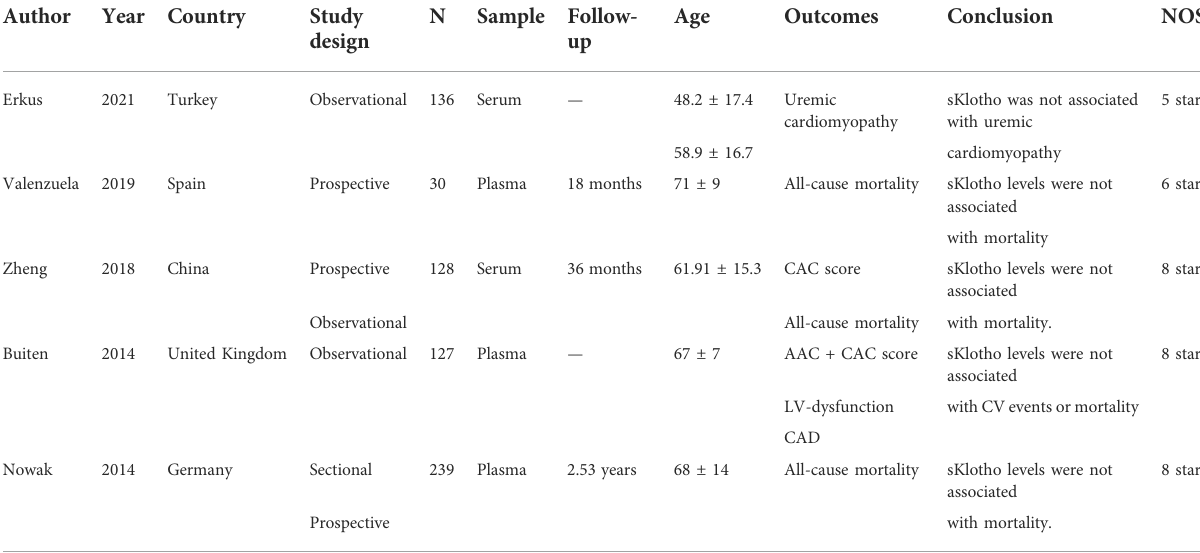
TABLE 3 Characteristics of the negative studies regarding the relationship of Klotho with adverse outcomes (Low versus high sKlotho level) in MHD